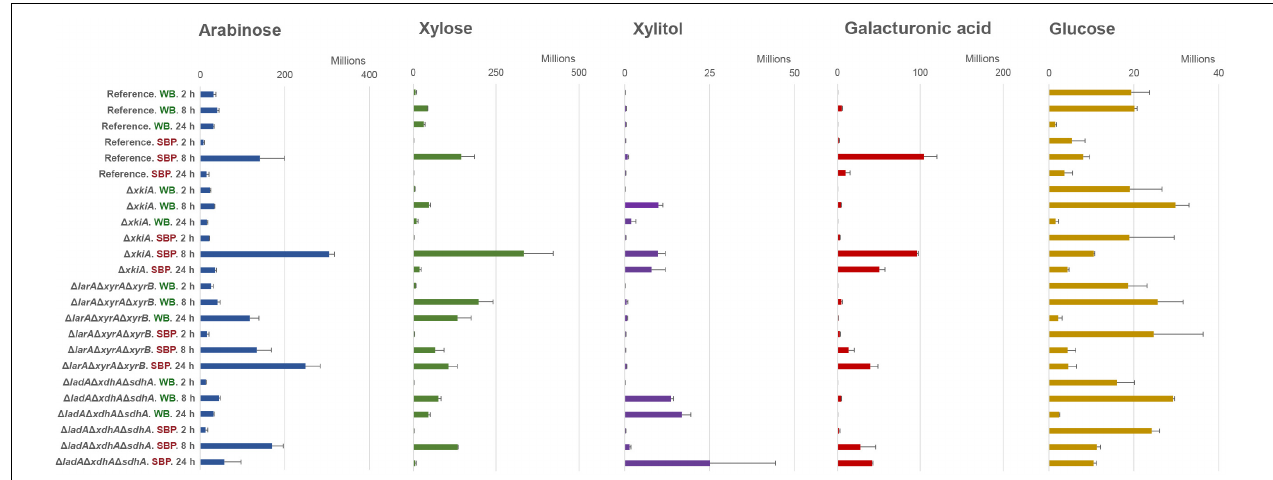
FIGURE 4 | Metabolite abundance in culture supernatant of arabinose, xylose, xylitol, galacturonic acid and glucose, after 2, 8, and 24 h transfer of the A. niger reference strain (N593 (cid:49) kusA ) and the PCP deletion mutants to 1% (w/v) wheat bran (WB) and 1% (w/v) sugar beet pulp (SBP). The error bars represent the standard deviation between three biological replicates.